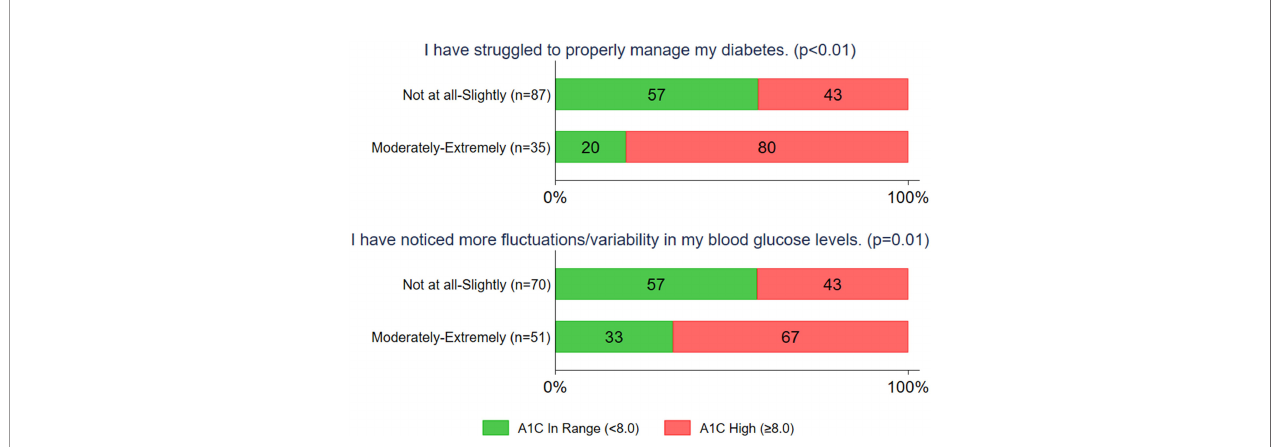
FIGURE 4 | Percentages with <8% and ≥ 8% A1C among subgroups of respondents who did or did not report problems with diabetes management since the COVID-19 pandemic. P values are from Chi square